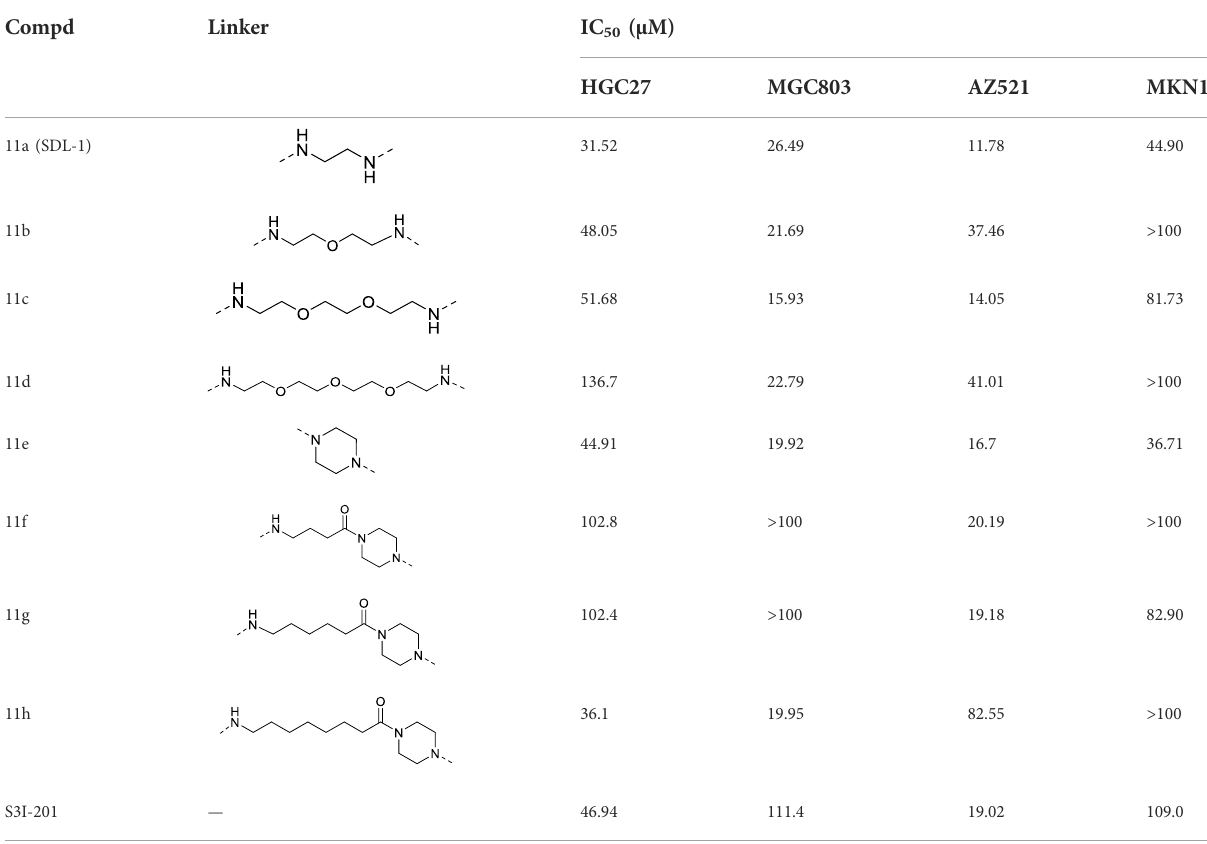
TABLE1InvestigatingtheeffectoflinkersontheantiproliferativeactivityofSTAT3PROTACstowardsfourhumangastriccelllines(HGC27,MGC803, AZ521, and